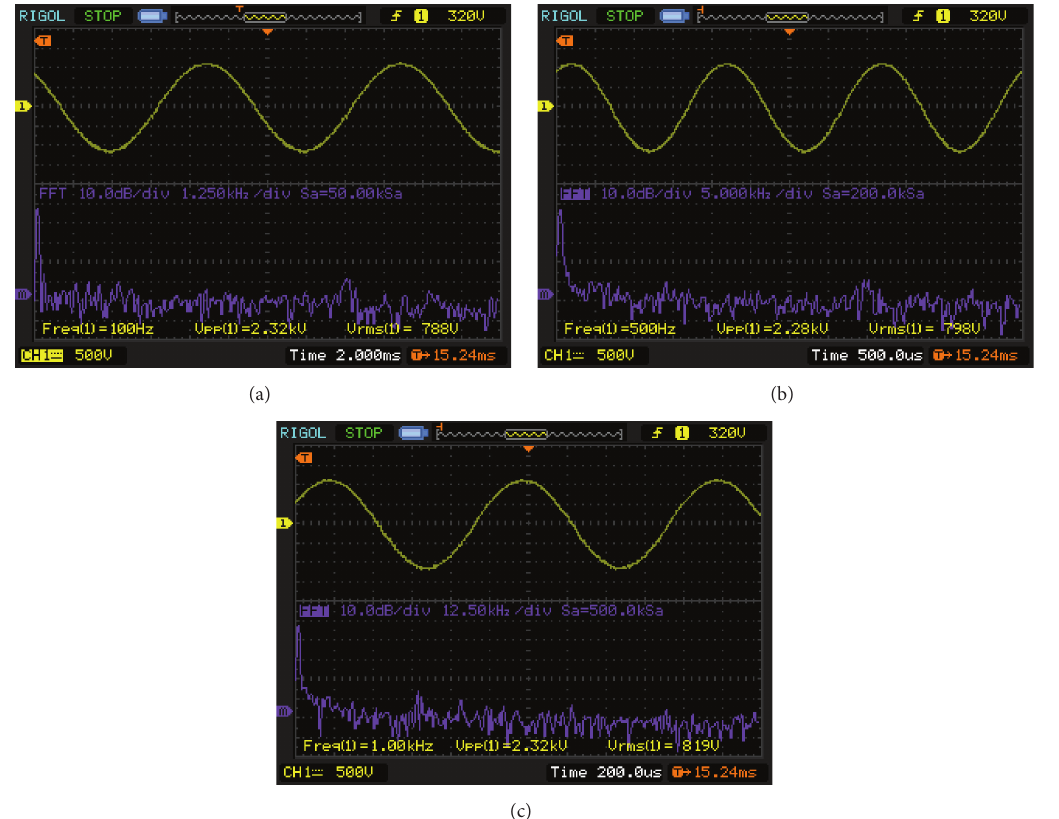
Figure 6: Oscilloscope screenshots of output voltage at frequencies of (a) 100 Hz (500V/div, 2ms/div), (b) 500 Hz (500 V/div, 500 us/div), and (c) 1000Hz (500V/div, 200 us/div).